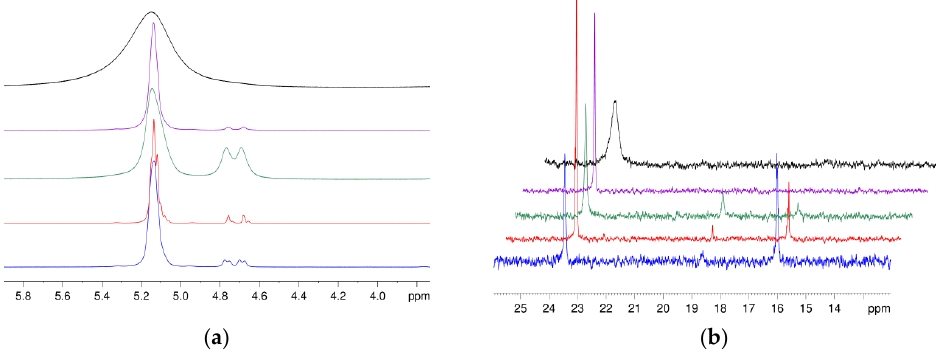
Figure 4. Comparison of 1 H NMR ( a ) and 13 C NMR spectra ( b ) of selected polyisoprene samples (sorted by microstructure: decreasing trans ‐ content bottom to top) produced by the systems Nd(AlMe 4 ) 3 ( 2 Nd )/[PhNMe 2 H][B(C 6 F 5 ) 4 ] ( B ) (blue; cis / trans /vinylic = 47/48/5%), La(AlMe 4 ) 3 ( 2 La )/2 B(C 6 F 5 ) 3 ( C ) (red; 78/19/4%), Dy(AlMe 4 ) 3 ( 2 Dy )/2 [Ph 3 C][B(C 6 F 5 ) 4 ] ( A ) (green; 72/10/18%), Nd(AlMe 4 ) 3 ( 2 Nd )/Me 2 AlCl ( D ) (violet, 99/0/1%) and Gd(AlMe 4 ) 3 ( 2 Gd )/Me 2 AlCl ( D ) (black; >99/0/0%). Inclusion of